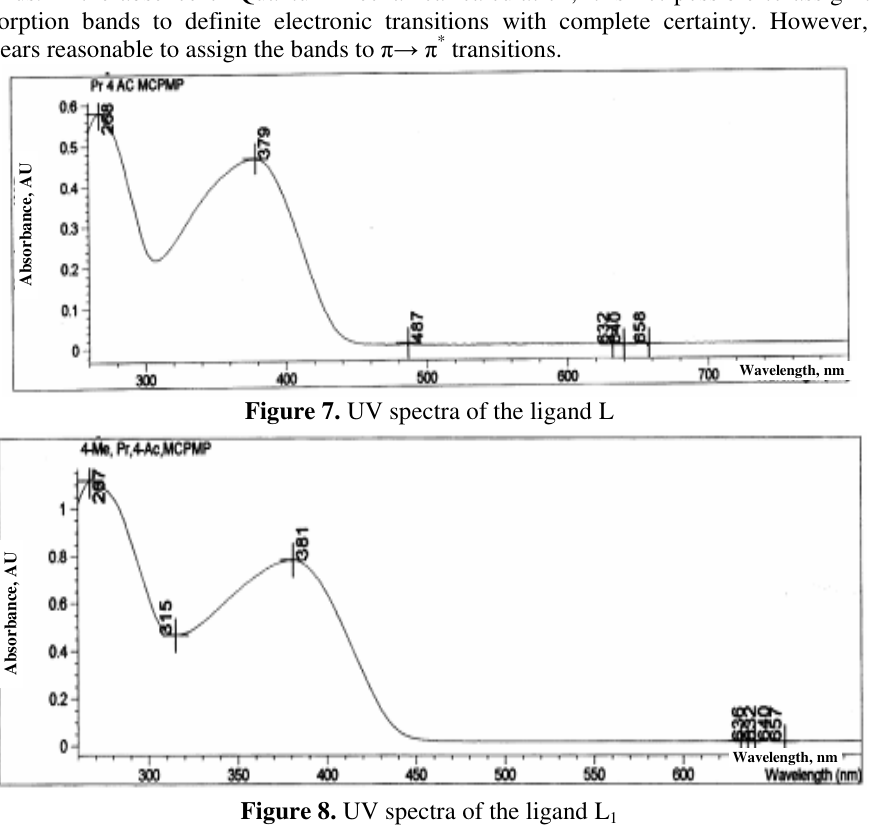
Figure 8. UV spectra of the ligand L